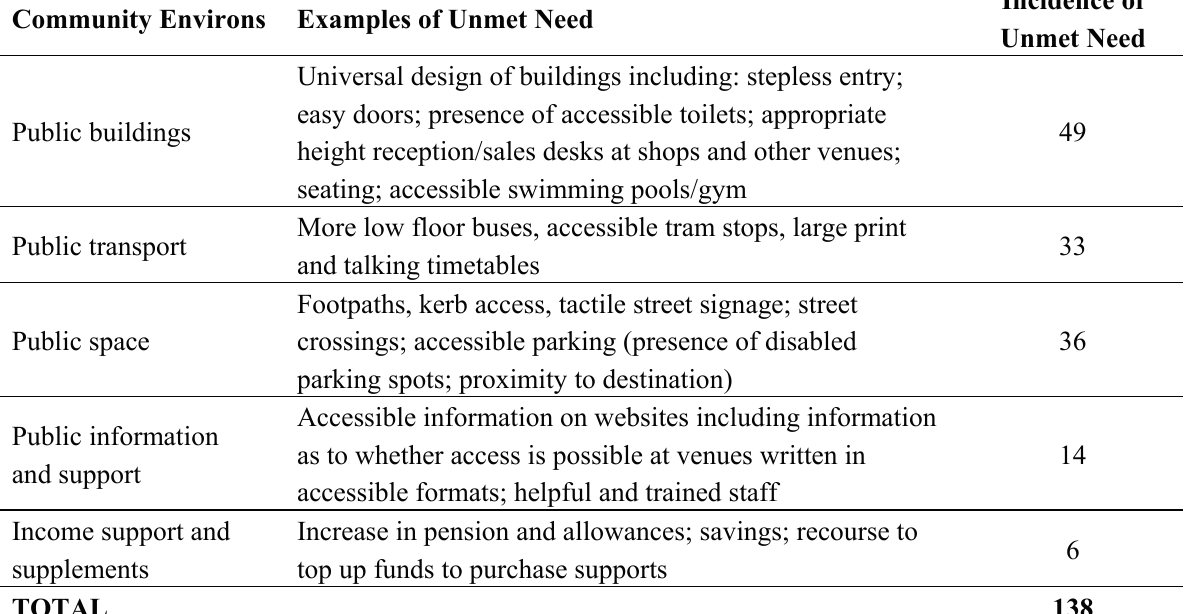
Table 4. Descriptions, examples and incidence of unmet need for inclusive community